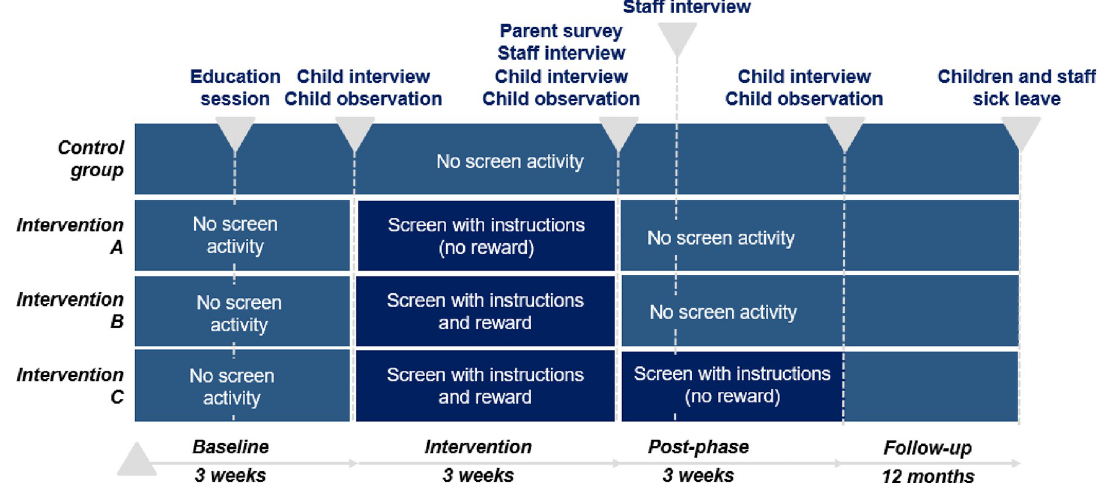
PLOS ONE | https://doi.org/10.1371/journal.pone.0280686 January 24,